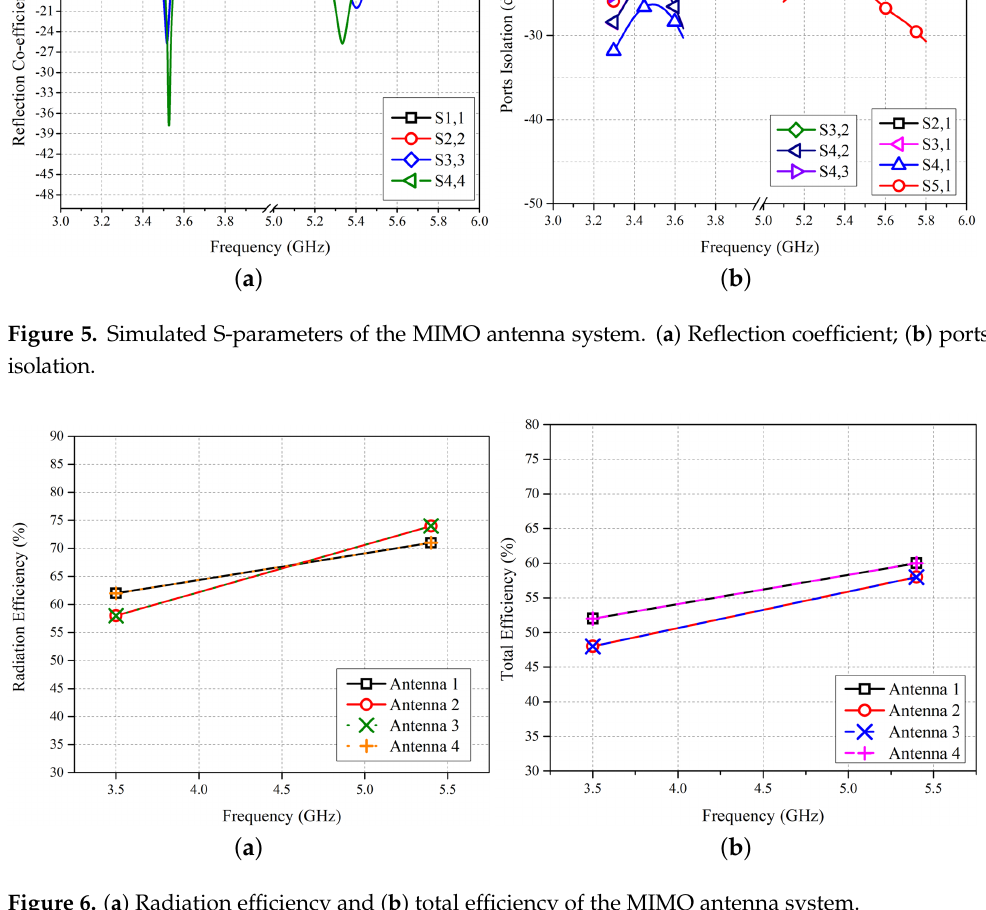
Figure 6. ( a ) Radiation efficiency and ( b ) total efficiency of the MIMO antenna